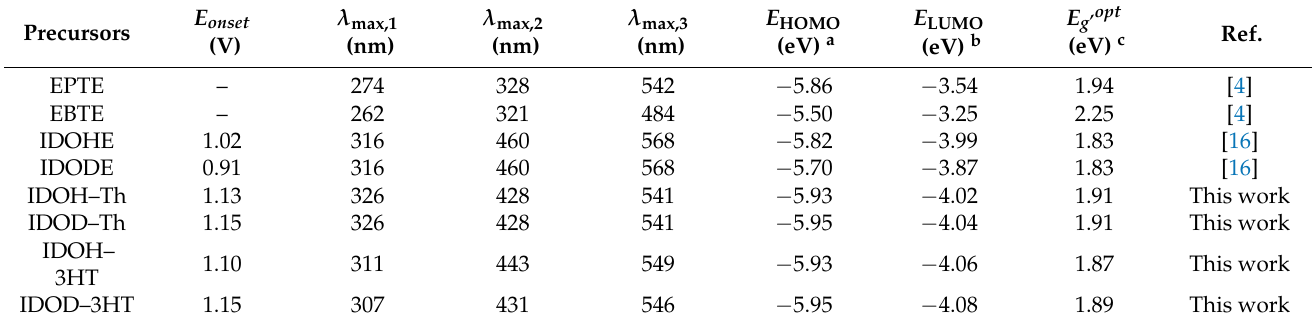
Table 1. Electrochemical and optical data for isoindigo–thiophene D–A–D–type precursors.